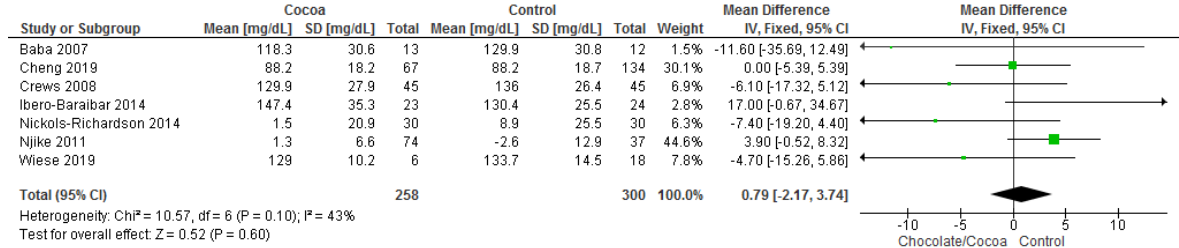
Figure 6. Forest plot of comparison: chocolate versus control, with the outcome - triglyceride (mg/dL). Figure 7. Forest plot of comparison: chocolate versus control, with the outcome - low density lipoprotein (mg/dL). Nichols- Richardson (2014) and Nijike (2011) reported mean changes and their respective SD, instead of mean scores. Figure 8. Forest plot of comparison: chocolate versus control, with the outcome - high density lipoprotein (mg/dL). Nichols- Richardson (2014) and Nijike (2011) reported mean changes and their respective SD, instead of mean scores.